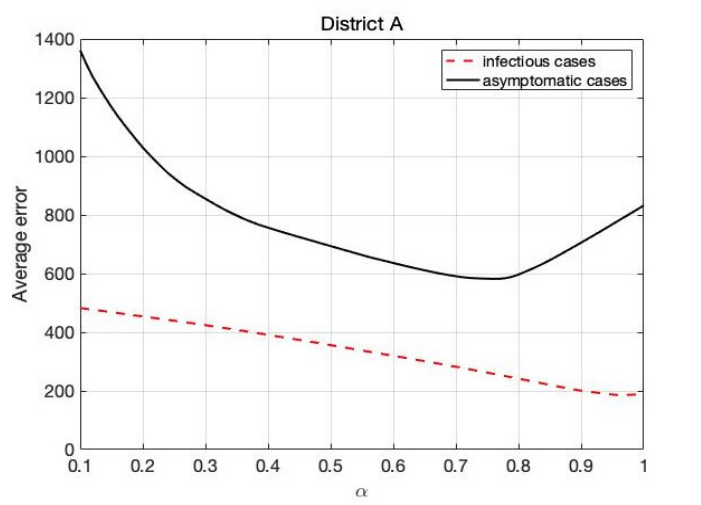
Figure 8. Model results for various